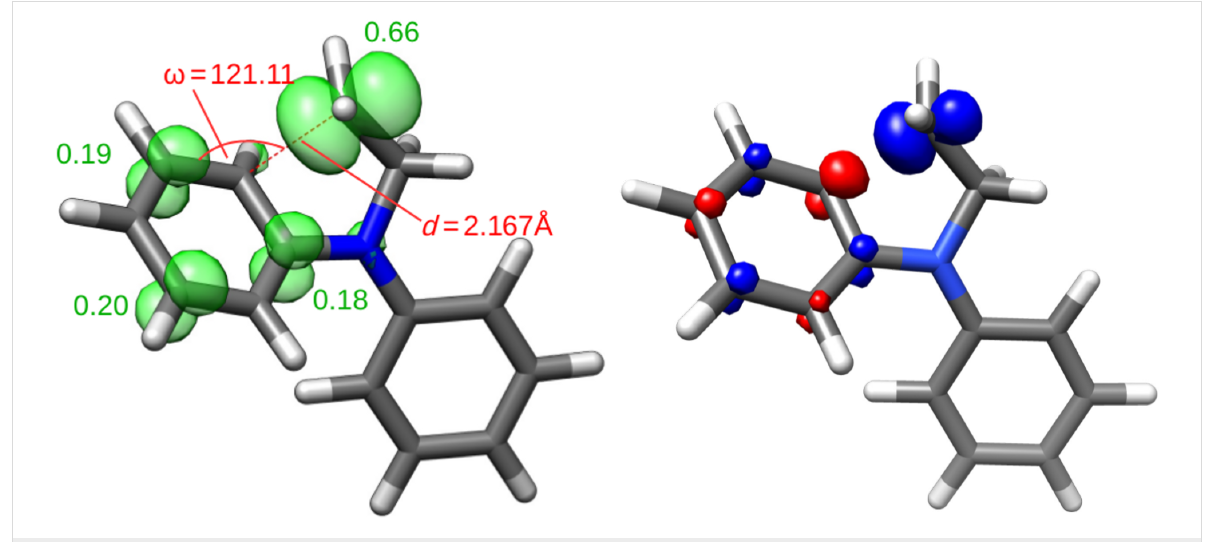
Figure 1: Optimized structure of the transition state of the radical addition of 1 (left: spin density plot and atomic spin-density populations; right: SOMO).